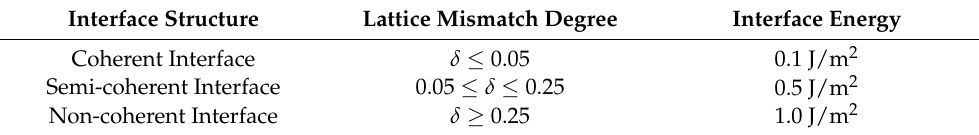
Table 2. The relationship among interface structure, lattice mismatch degree, and interface